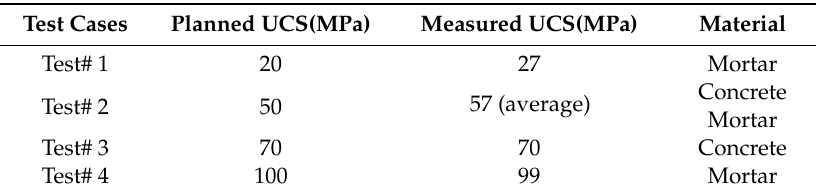
Table 2. Test cases having variation of UCS in this study.